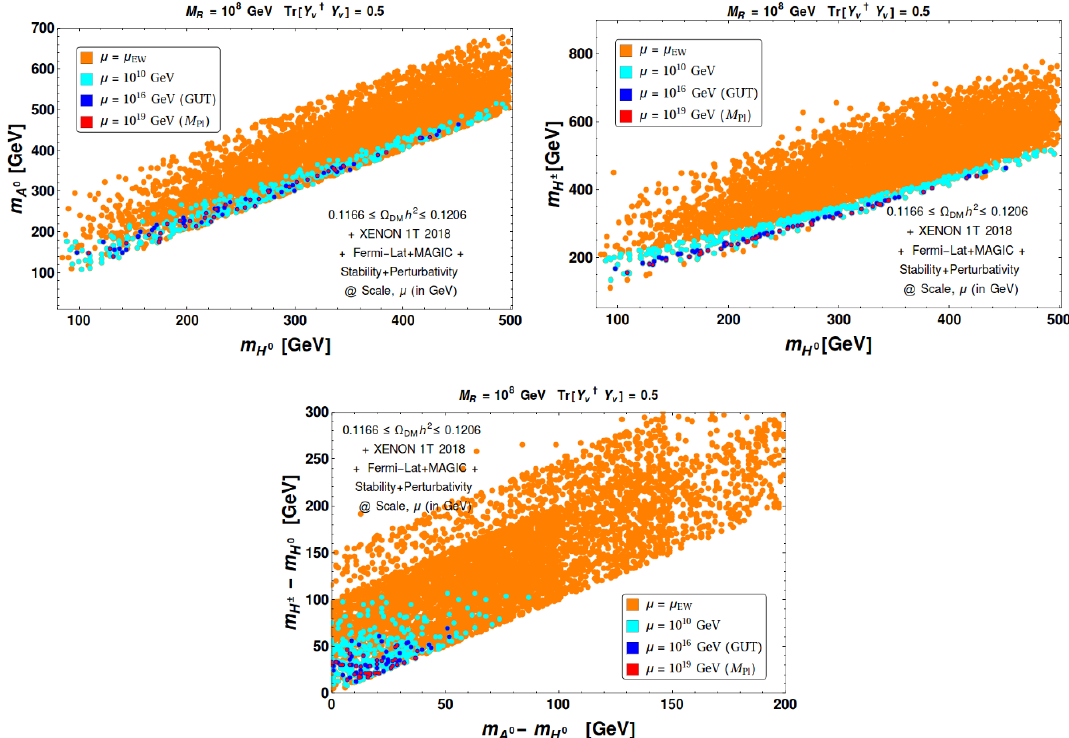
Figure 27 . Relic density direct search and indirect search allowed points (orange) in m (top left), m (cid:0) m (top left) and (cid:1) m (= m H 0 H (cid:6) further apply stability and perturbativity conditions following eqs. (3.1){(3.5) at di(cid:11)erent